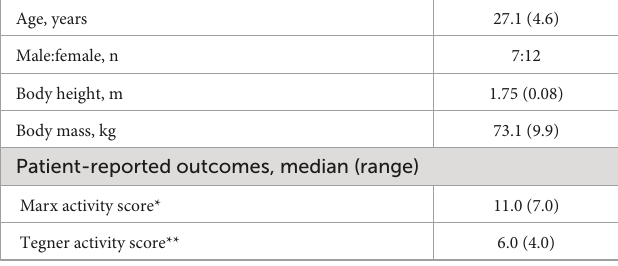
The protocol involved three experimental conditions: (1)